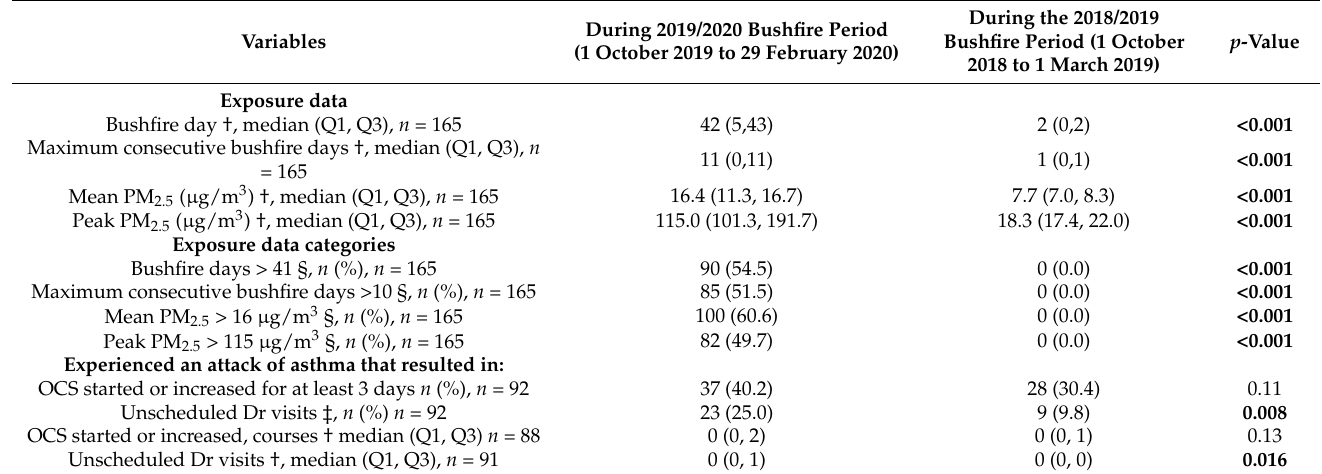
Table 3. Bushfire smoke exposure and asthma attacks during the 2019/2020 bushfire period compared to the 2018/2019 bushfire